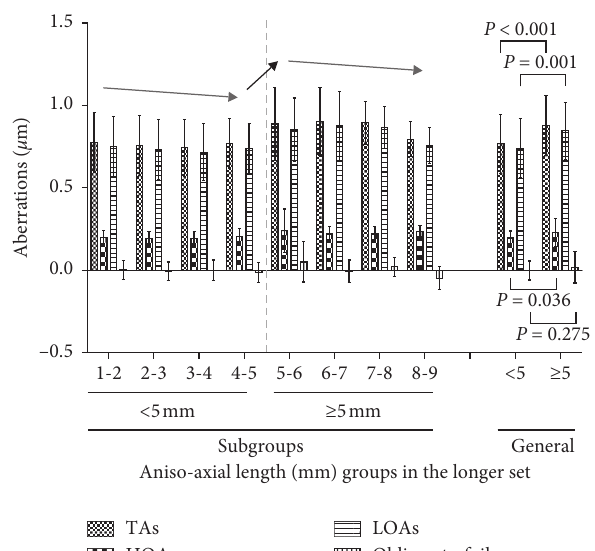
Figure 3: Distribution of posterior corneal aberrations among the eight subgroups in the longer set. TAs � total aberrations; HOAs � high-order aberrations; LOA � low-order aberrations. For the aniso-axial length subgroups, a value of 1mm is included in the 1-2mm subgroup and similarly for other values that fall at the boundary between two subgroups. The P values for TAs, HOAs, LOAs, and oblique trefoil with analyses of variance among the eight aniso-axial length subgroups in the longer set were 0.025, 0.005, 0.039, and 0.040, respectively. The P values for TAs, HOAs, LOAs, and oblique trefoil using independent Student’s t test between aniso-axial length eyes in the longer set with and without AL ≥ 5mm were < 0.001, 0.036, 0.001, and 0.275,